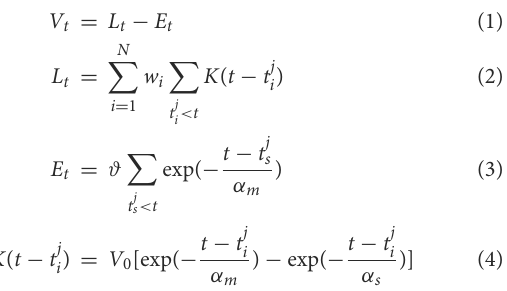
brightness while p = − 1 means the decreasing brightness. The 3D visualization of the event stream is illustrated in Figure 1A, which indicates a rotated star. Figure 1B shows the time surface of the rotated star, where the color from yellow to blue represents the time trajectory from old to new events. From this we can deduce that the star is moving